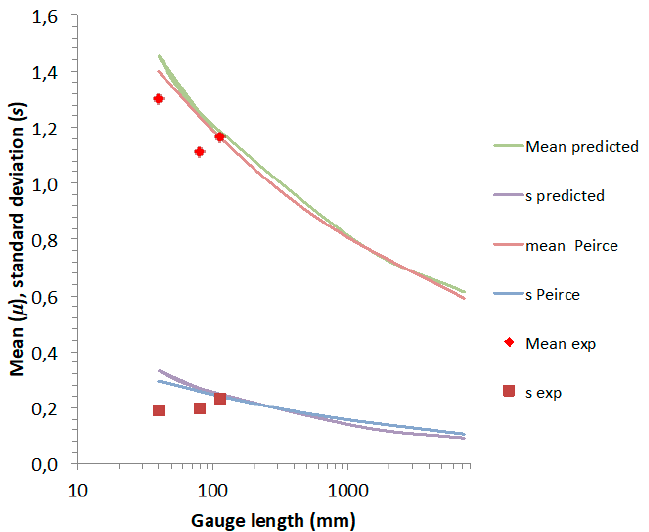
Figure 8. Predictions from 115 mm quantile diagram: mean ( µ ) and standard deviation ( s ) values derived from the p-quantile diagrams predicted for various gauge lengths and mean and standard deviation values calculated using Peirce’s equations.